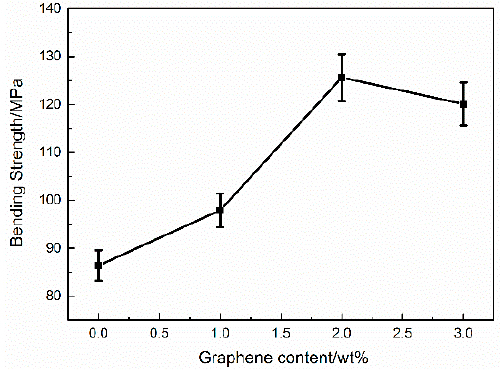
Figure 3. Bending strength of the graphene/H-EP composites (Error bars are standard deviatiion).